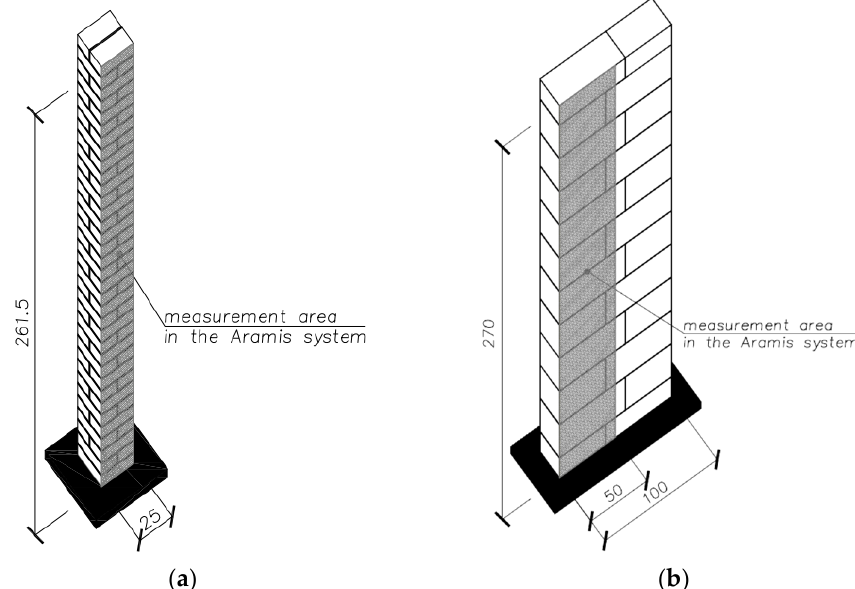
Figure 17. Measurement area in the Aramis system for ( a ) a model of clay brick pillars, ( b ) a masonry wall model made of autoclaved aerated concrete blocks.